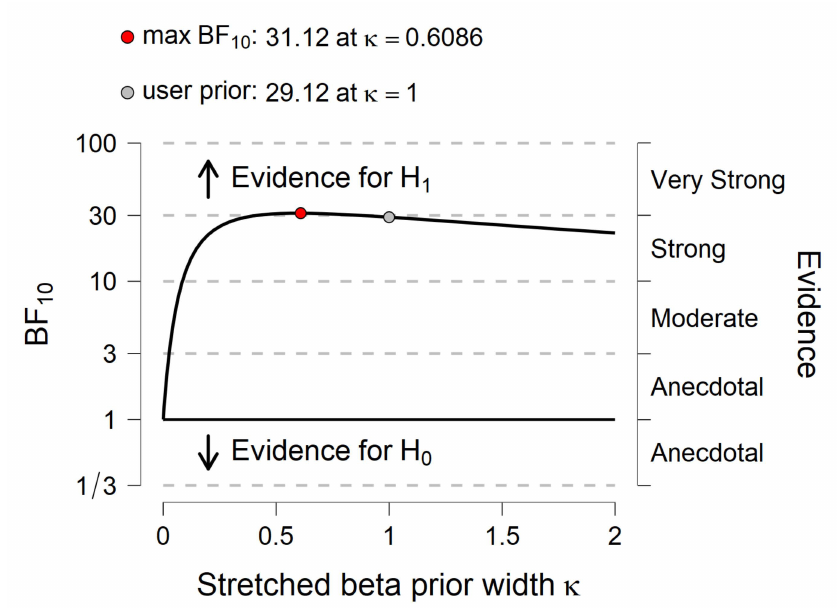
Figure 3. Bayes Factor (BF) robustness